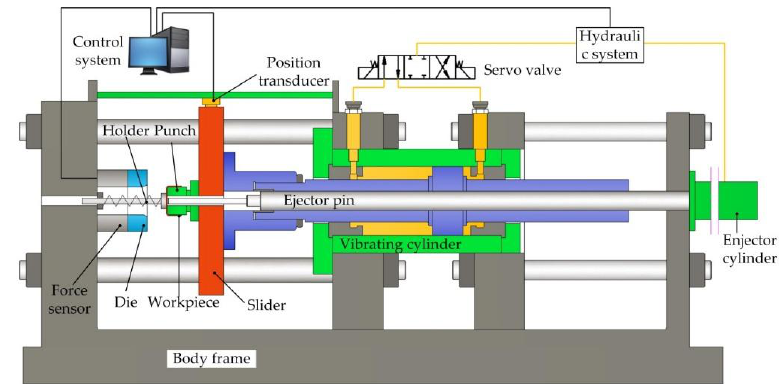
Figure 3. Schematic of a vibration-assisted hydraulic extrusion press.